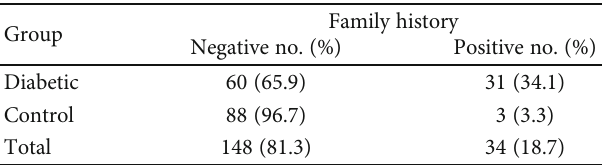
Table 4: Family history distribution for type 1 diabetes among both groups.